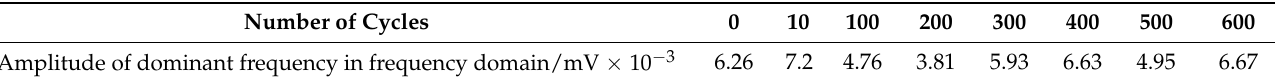
Table 3. Amplitude information of acoustic emission signals of Group A batteries during charge.